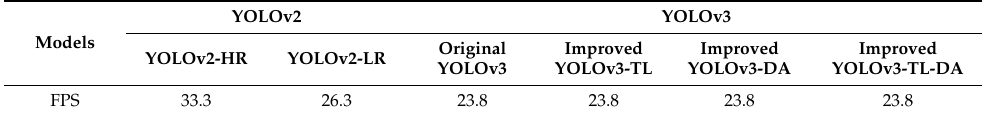
Table 4. Detection speed (FPS) of the YOLOv2 and